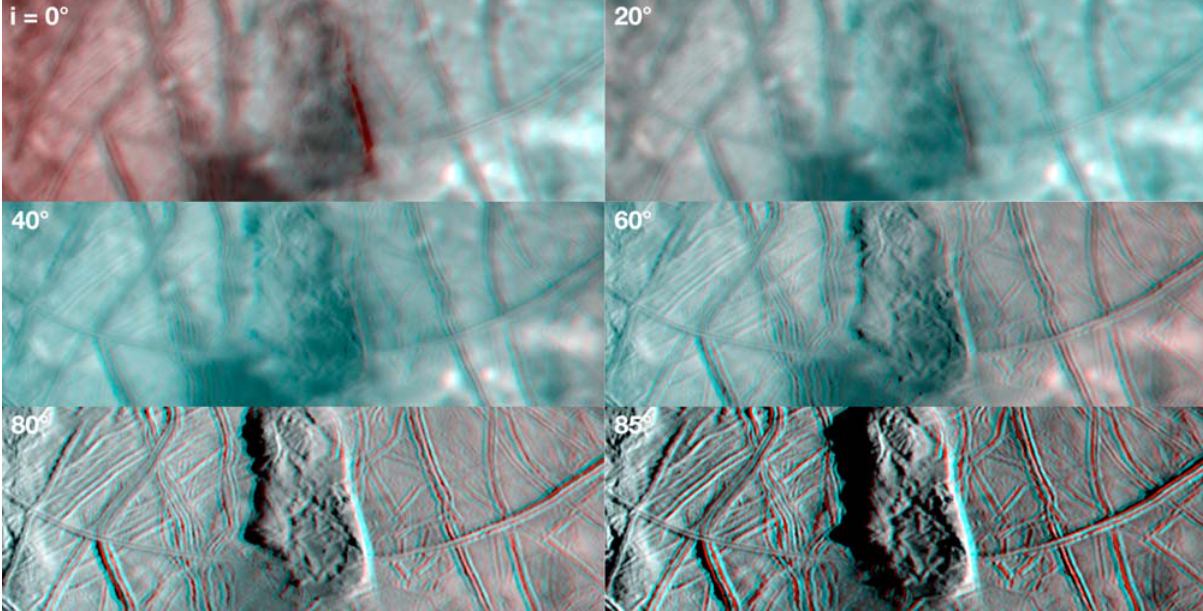
Figure 2. Examples of simulated stereo images of Castalia Macula, Europa, showing the effect of varying incidence angles i as labeled. Sun azimuth is 0° (directly from the right) in all cases. A subarea centered on one of the domes is shown at full 210 m/pixel scale in anaglyph form (view with red lens on the left eye, cyan lens on the right eye). The color gradients visible in the images are the result of the variation of phase angle across the two images, combined with the realistic photometric function